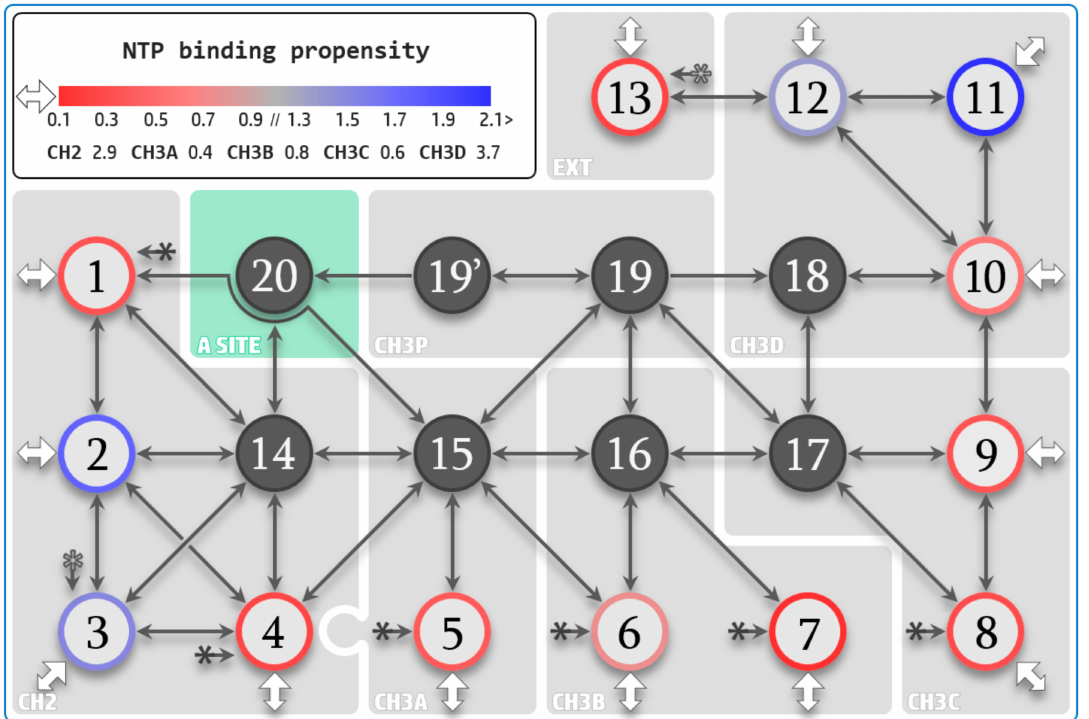
Figure 4. NTP di ff usion map. Amino acids lying about the path of substrate di ff usion are divided into twenty macro-regions (MR). Entry MR1 to 13 are shown as color-contoured discs, where the disc contour codes propensity to NTP binding. MR13, located externally (indicated by “EXT”) to solvent pathways, connects MR3 and MR12. Infiltration MR14 to 20, defined as not accessible directly from bulk solvent, are shown as grey discs. “A site” designates the active site region encompassed by MR20. MR19 (cid:48) denotes necessary downstream NTP isomerization against the bridge helix before transfer to MR20. Solid and empty star symbols represent connections that are not fully drawn. White arrows indicate initial di ff usion from the bulk solvent to the entry sites. The binding propensities are defined as the average number of bound NTPs during aggregate simulation time and are indicated for the entry macro-regions. Propensities are also listed for CH2, CH3A / B / C / D overall, and are defined as the cumulative average amount of NTPs bound to MR1 / 2 / 3 / 4 / 14 for CH2, MR5 / 15 for CH3A, MR6 / 7 / 16 for CH3B, MR8 / 9 / 17 for CH3C, and MR10 / 11 / 12 / 18 for CH3D. MR1 / 4 / 5 / 6 / 7 / 8 are interconnected through a common junction area (solid star symbol connection). The CH3A and CH2 pathways (MR5 and MR1 / 4) overlap about the funnel region (represented by the imbrication of the grey shaded